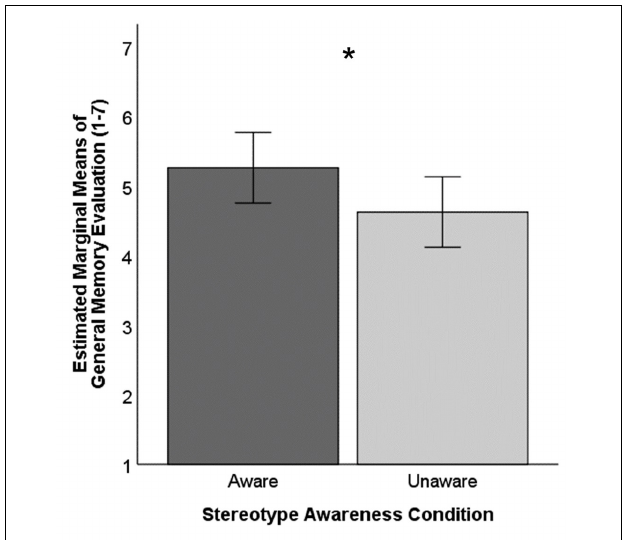
FIGURE 3 | Evaluation of memory ability by stereotype awareness. Error bars represent 95% confidence intervals. Covariate age (in years) evaluated at 65.05. * Indicates significant mean difference, p <